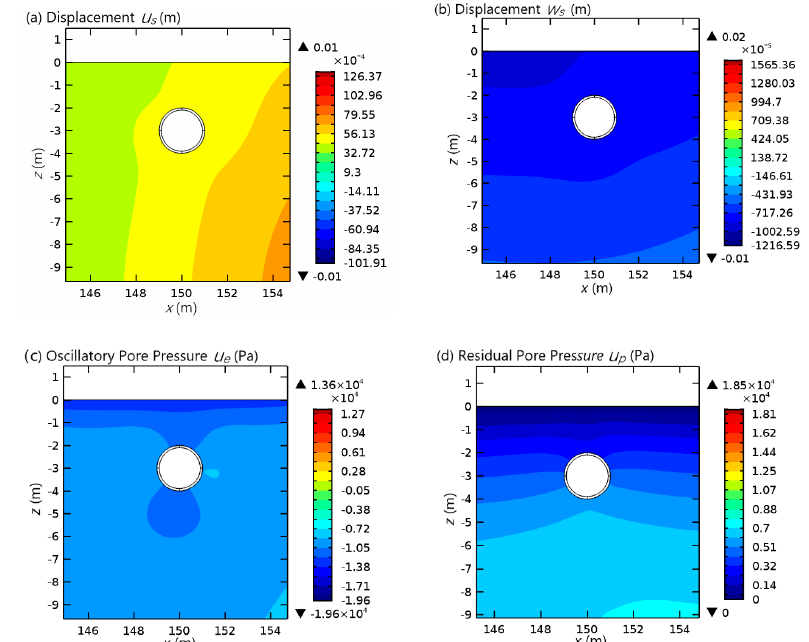
Figure 9. Distribution of seabed responses such as ( a ) horizontal displacement u s , ( b ) vertical Figure 8. Distribution of seabed responses such as ( a ) horizontal displacement 𝑢 (cid:3046) , ( b ) vertical displacement 𝑤 (cid:3046) , (c) oscillatory pore pressure, 𝑢 (cid:3032) , and residual pore pressure 𝑢 (cid:3043) around the vicinity displacement w s , ( c ) oscillatory pore pressure, u e , and residual pore pressure u p around the vicinity of the buried pipeline due to wave and current loading when current velocity is set at 𝑣 (cid:3030) = 0.5 m/s.